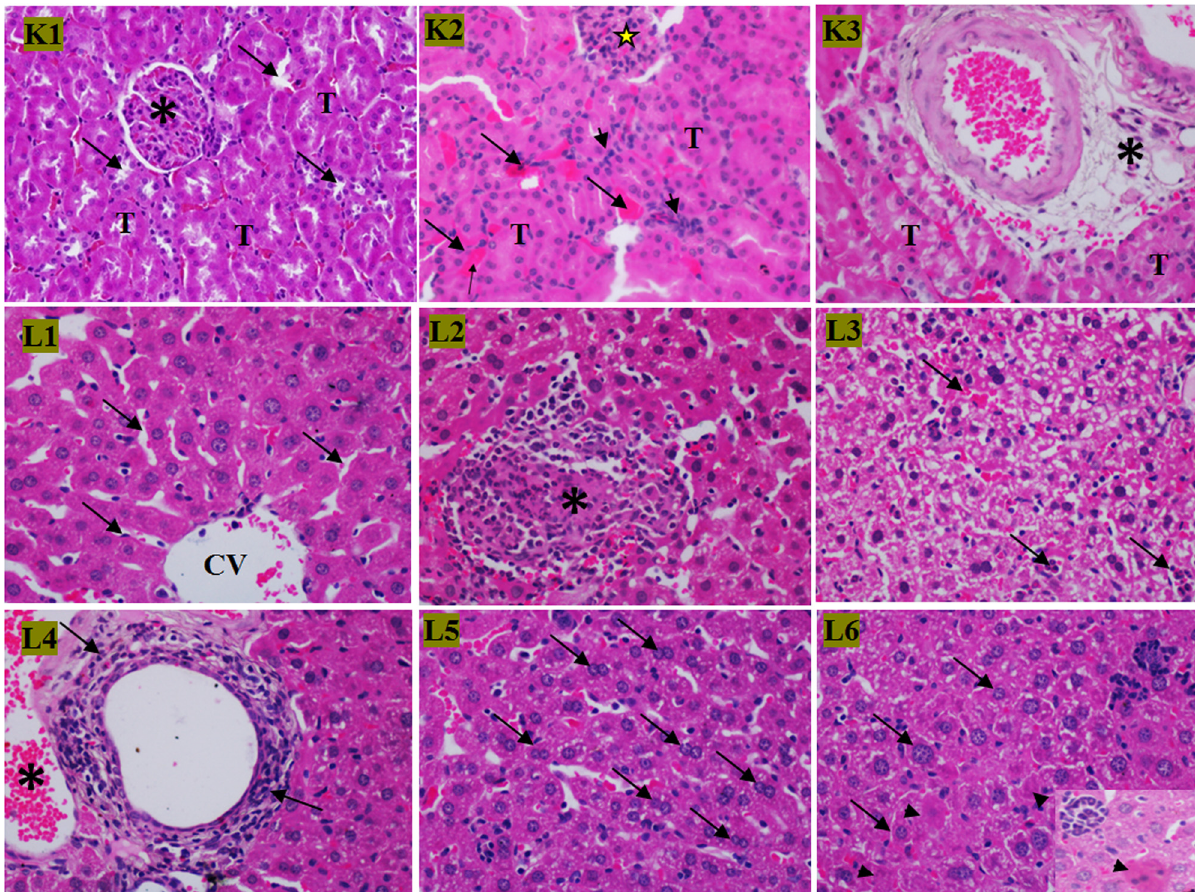
Figure 5: K ( 1 – 3 ) Histological sections of the kidney of control and PHF5 - treated mice. ( 1 ) Control mice receiving corn oil vehicle ( 200µL/kg/body weight ) demonstrating normal histological architecture of kidney, glomeruli ( * ) , kidney tubules ( T ) , and intercellular tissue ( arrows ) . H&E stain 400 × . ( 2 ) PHF5 - treated group ( 2,000mg/kg/day ) showing mild congestion of intertubular blood vessels ( arrows ) , mild focal interstitial in fl ammation ( arrow heads ) , and normal cortical kidney tubules ( T ) . H&E stain 400 × . ( 3 ) PHF5 - treated group ( 2,000mg/kg/body weight ) showing perivascular edema ( * ) , hydropic degeneration changes in the kidney tubules ( T ) . H&E stain 400 × . L ( 1 – 6 ) Histological sections of the liver of control and PHF5 - treated mice. ( 1 ) Control mice receiving corn oil vehicle ( 200mL/kg/body weight ) showing normal morphology of liver and absent lesion area, with normal - appearing central vein ( CV ) , parallel cords of hepatocytes radiating from the central vein toward the periphery of the hepatic lobule, separated by sinusoidal spaces ( arrows ) . H&E stain 400 × . ( 2 ) PHF5 - treated group ( 2,000mg/kg/body weight ) showing granulomas ( * ) . H&E stain 400 × . ( 3 ) PHF5 - treated group ( 2,000mg/kg/body weight ) showing hydropic degenerative changes in the ballooning hepatocytes and in fi ltration of neutrophils ( arrows ) in blood sinusoids. ( H&E; 400 × , original magni fi cation. ) ( 4 ) PHF5 - treated group ( 2,000mg/kg/body weight ) showing congested hepatic portal vein ( * ) with in fi ltration of in fl ammatory cells around the branch of the hepatic artery ( arrows ) in the portal area ( H&E; 200 × , original magni fi cation ) . 5PHF5 - treated group ( 2,000mg/kg/body weight ) showing binucleation ( arrows ) in the hepatocytes ( H&E; 400 × , original magni fi cation ) . ( 6 ) PHF5 - treated group ( 2,000mg/kg/body weight ) showing anisokaryosis ( arrows ) , focal necrosis ( arrowheads ) , and apoptotic bodies ( inset ) ( H&E; 400 × , original magni fi cation )